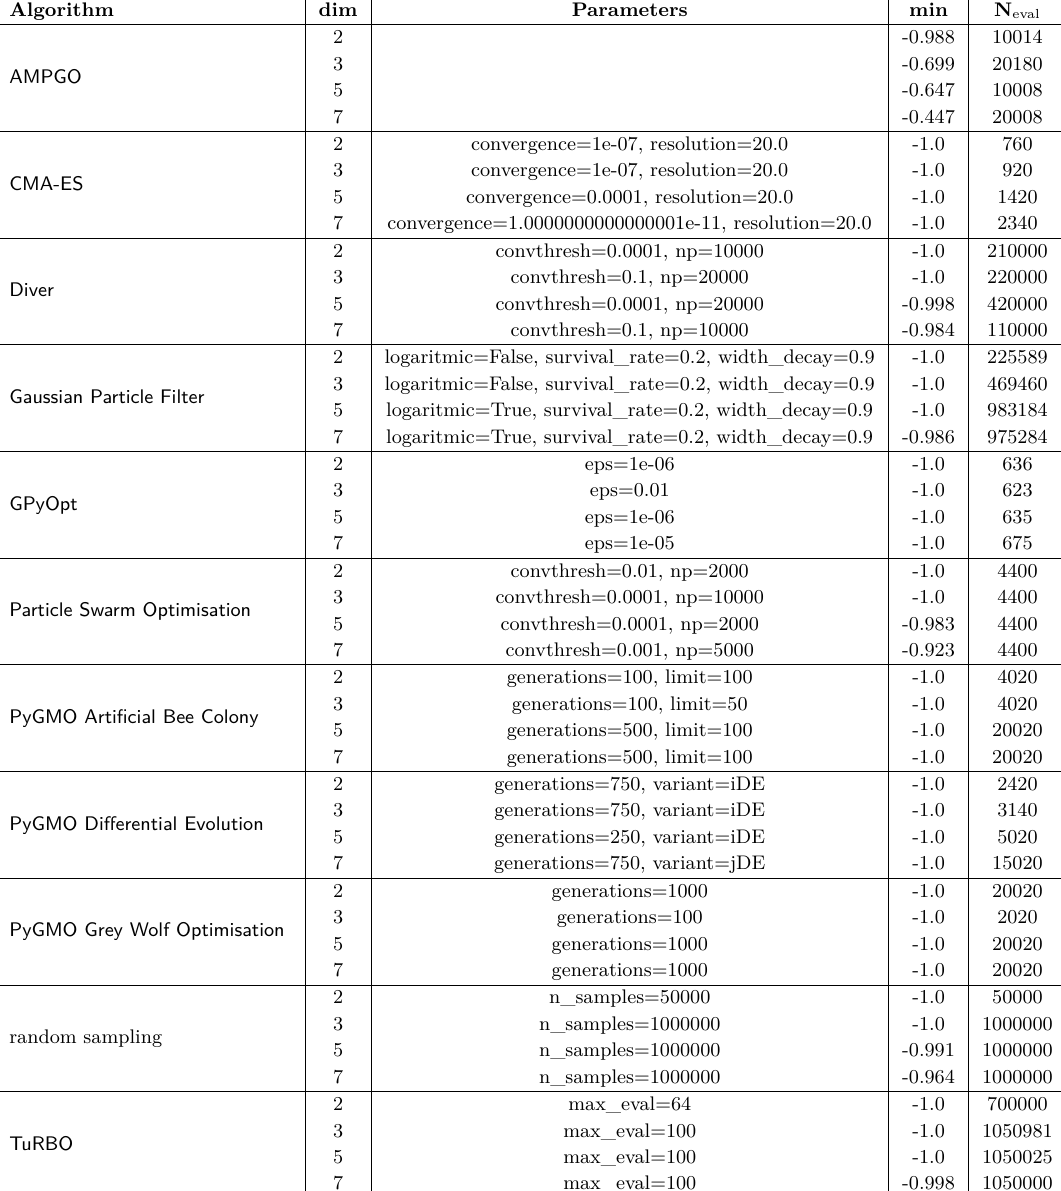
Table 5. Best obtained result for Analytic Function 3 (equation (3.3)). The ‘best’ result is the result with the lowest found function value. If multiple samples found the same value, the result with the fewest number of needed function evaluations is